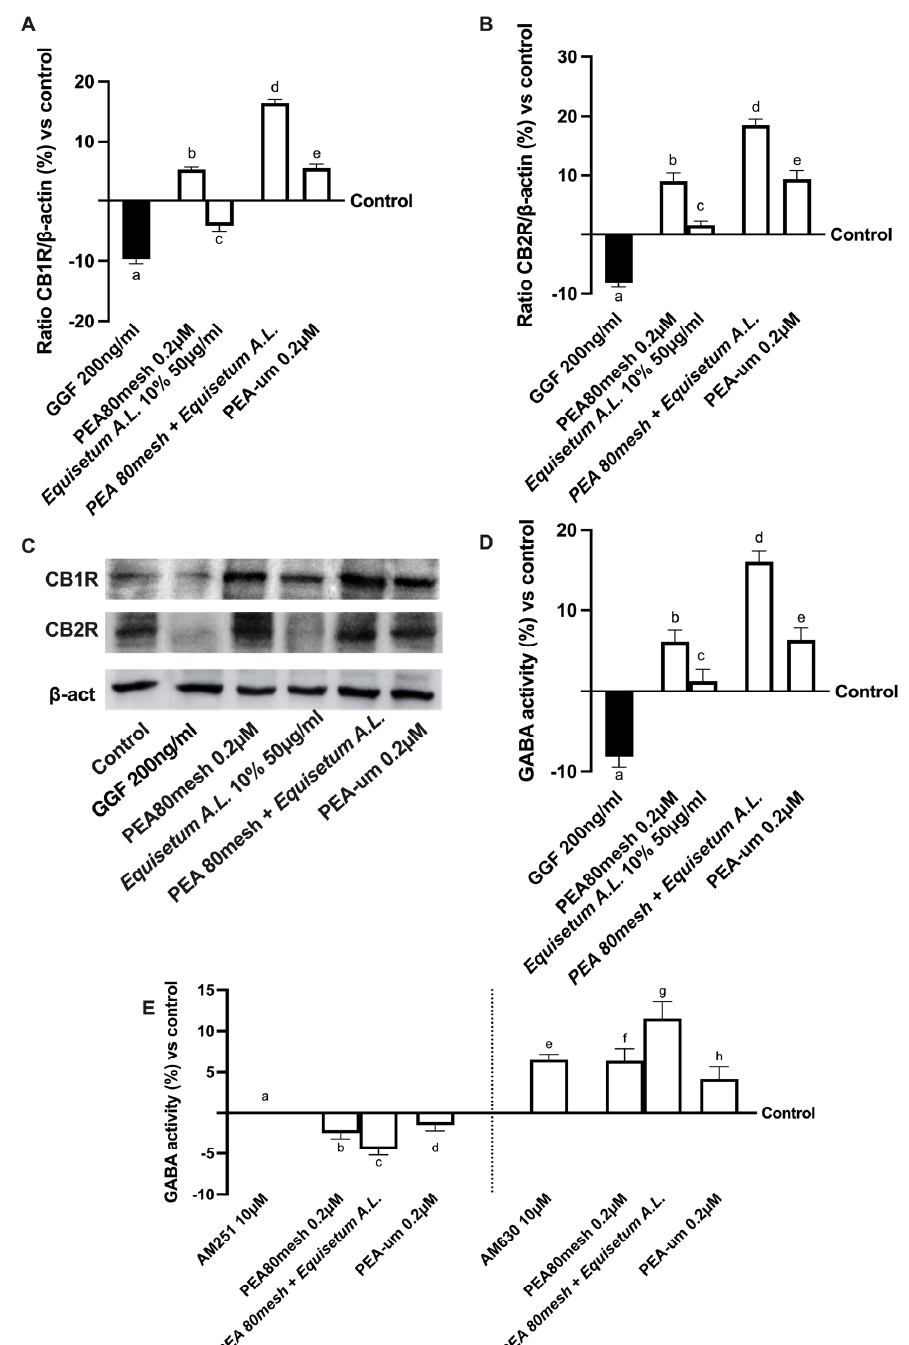
Figure 4. Analysis of EquiPEA™ on CB1/2 receptors and GABA activity under PNI conditions In ( A ) cannabinoid receptor type 1 (CB1R) and in ( B ) cannabinoid receptor type 2 (CB2R) densitometric analysis of the specific Western blot, which is reported as an example in ( C ); in ( D , E ) gamma-aminobutyric acid (GABA) activity by ELISA test in the absence or presence of CB1/2 blockers. The data are the mean ± SD (%) of five independent experiments performed in triplicate and normalized to control values (the 0% line). The abbreviations are the same as those reported in Figure 3. In ( A ): a, b, d, e, p < 0.05 vs. control; a p < 0.05 vs. b–e; b p < 0.05 vs. c, d; c p < 0.05 vs. d, e; d p < 0.05 vs. e. In ( B ): a, b, d, e, p < 0.05 vs. control; a p < 0.05 vs. b–e; b p < 0.05 vs. c, d; c p < 0.05 vs. d, e; d p < 0.05 vs. e. In ( D ): a, b, d, e p < 0.05 vs. control; a p < 0.05 vs. b–e; b p < 0.05 vs. c, d; c p < 0.05 vs. d, e; d p < 0.05 vs. e. In ( E ): e–g p < 0.05 vs. control; e p < 0.05 vs. g; f p < 0.05 vs. g; g p < 0.05 vs.